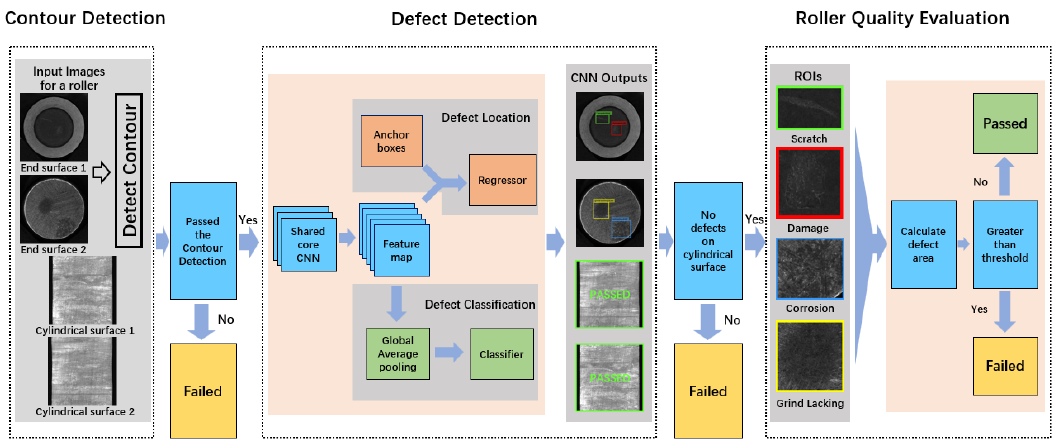
Figure 5. Surface inspection process. CNN: Convolutional Neural Networks; ROI: Region of Interest